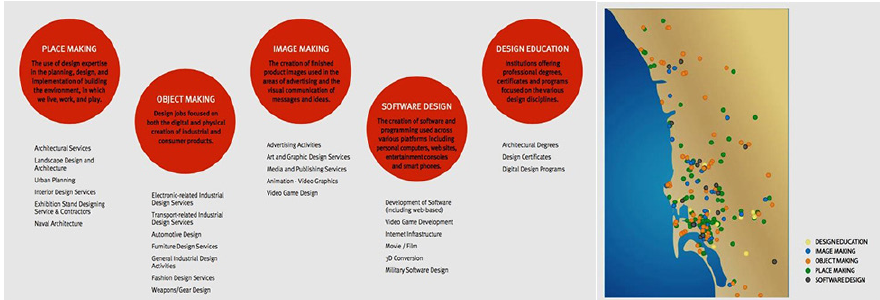
Figure 4. The 5 components of a design cluster and its location within the San Diego County (I.D.E.A. District,